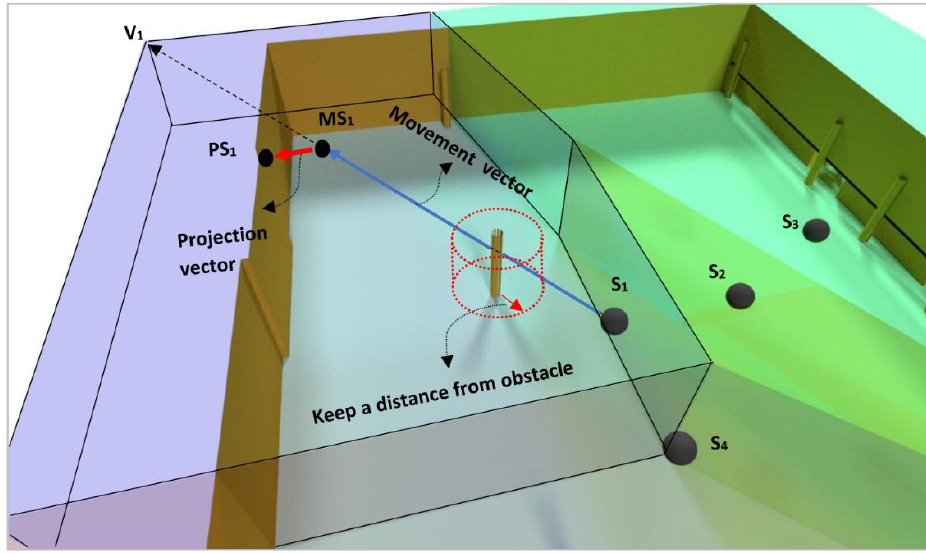
Figure 5. Movement strategy of sensors inside a 3D space based on a 3D Voronoi diagram (colored 3D cells) with consideration of projection and obstacle avoidance.